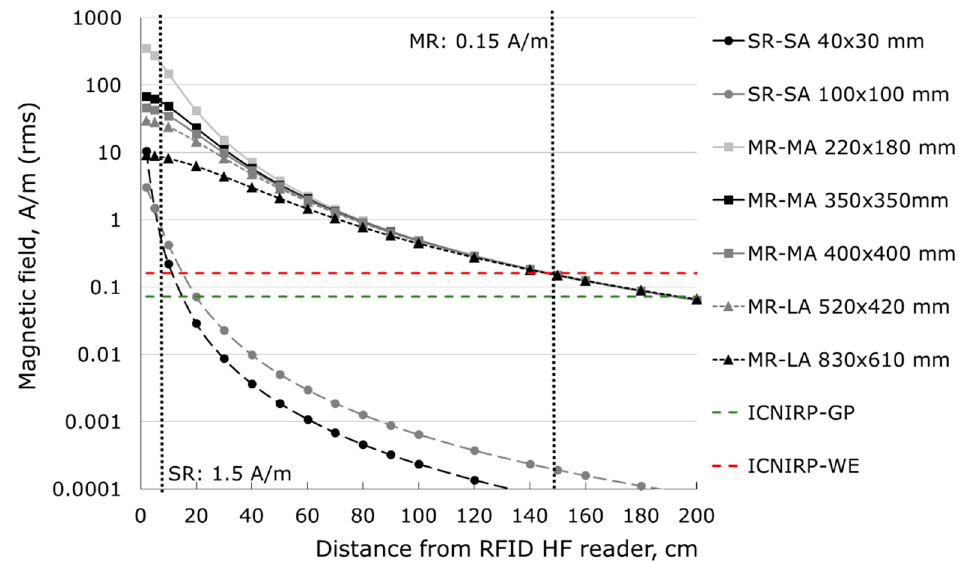
Figure 1. Electromagnetic field (EMF) distribution (magnetic component) in the function of distance from high frequency radiofrequency identification (RFID HF) readers with antennas of various dimensions set at the maximum reading range, along the axis of the reader (SR—short-range reader with a maximum reading range of 5 cm, MR—medium-range reader with a maximum reading range